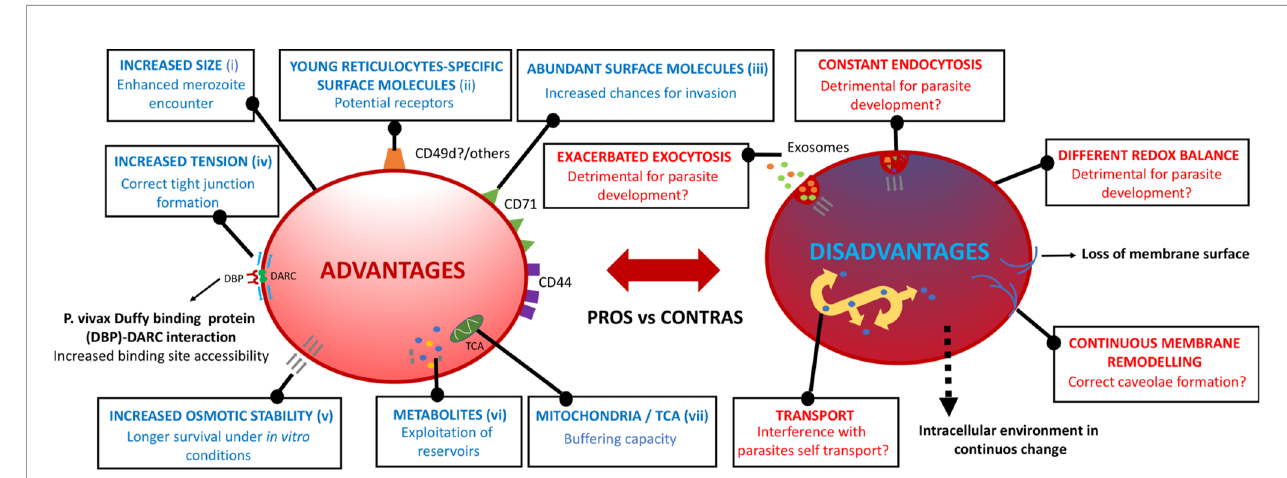
FIGURE 2 | Potential advantages and disadvantages of immature reticulocytes. Surface and intracellular phenotypic features at the very initial steps of very immature reticulocyte maturation that may confer/impede the P. vivax parasite ’ s subsequent physiological progression throughout their intra-reticulocytic developmental cycle. (i) Grif fi ths et al., 2012, (ii) Thomson-Luque et al., 2018, (iii) Malleret et al., 2013, (iv) Kariuki et al., 2020, (v) Clark et al., 2021, (vi) Srivastava et al., 2015, (vii) Starkov,